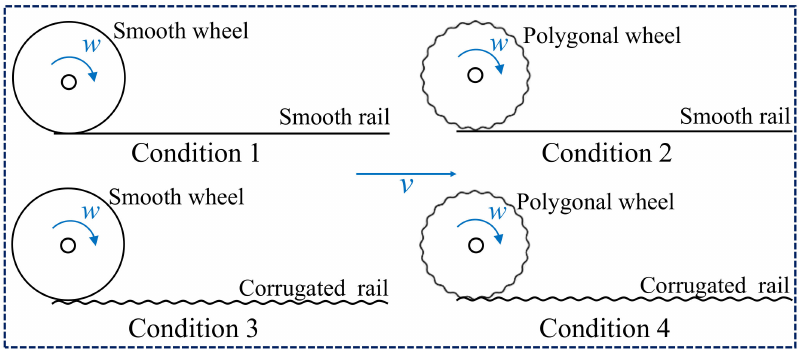
Figure 6. Different wheel–rail contact conditions.